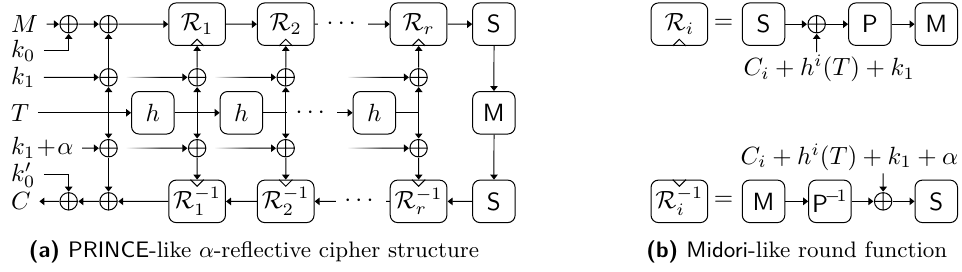
Figure 1: Design of the tweakable block cipher MANTIS r